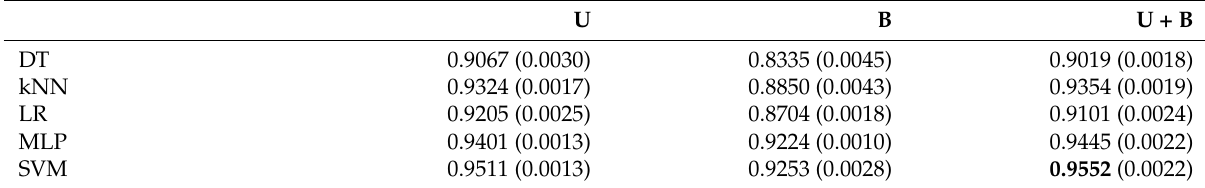
Table 1: Supervised learning WSD accuracies (standard deviations) with bag-of-words as local features.